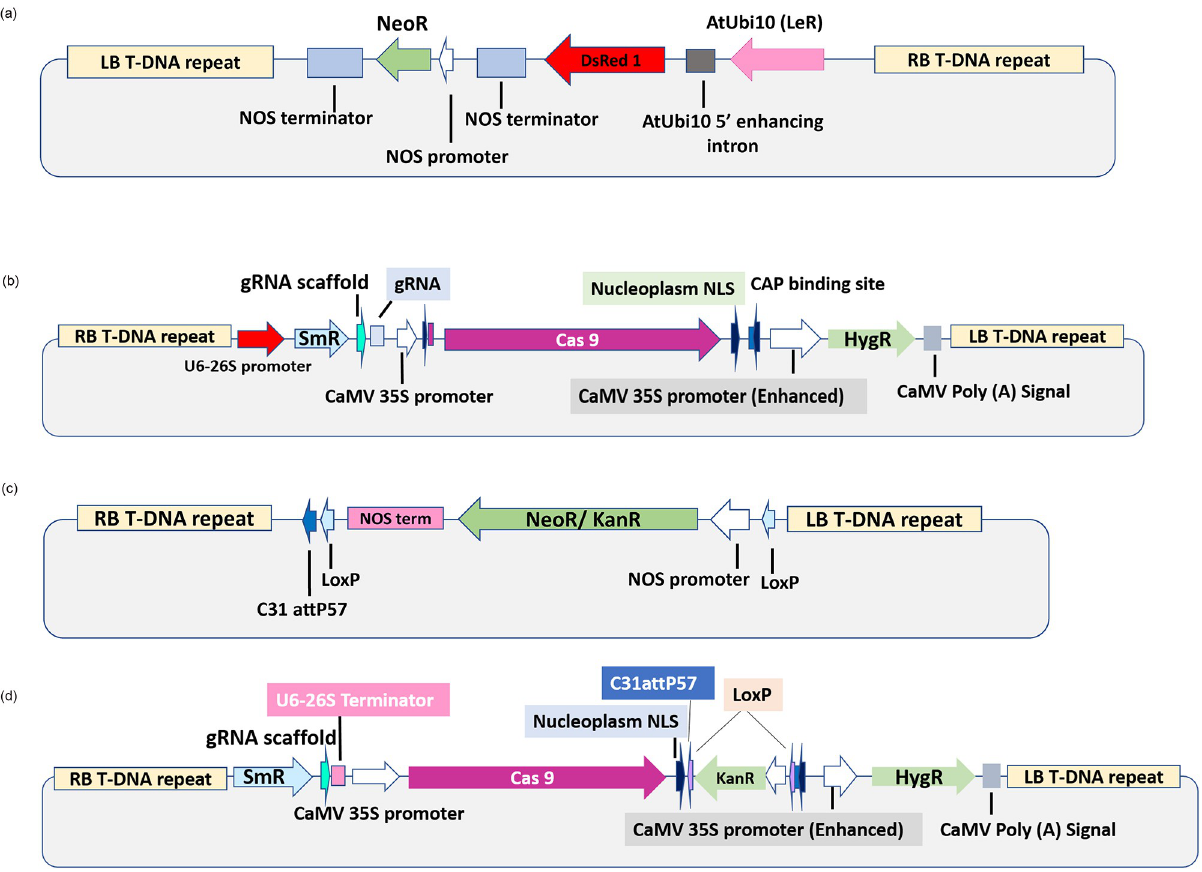
Fig 1. (a) pKGW-RR. DS-Red gene in pKGW-RR is transcribed by AtUbi10 (Ler) promoter and Nos terminator for plant expression. pKGW-RR was isolated from E . coli cells and digested for confirmation before Agro -transformation. pKGW-RR vector was used for optimizing Coker-312 transformation protocol for visualizing each step of transformation procedure. (b) pHSE-401-Rep. pHSE-401-Rep carried Cas9 gene (transcribed by CaMV 35S promoter) and a gRNA to target conservative region of Rep gene for Cotton Leaf Curl Khokran Virus (CLCuKV). This construct